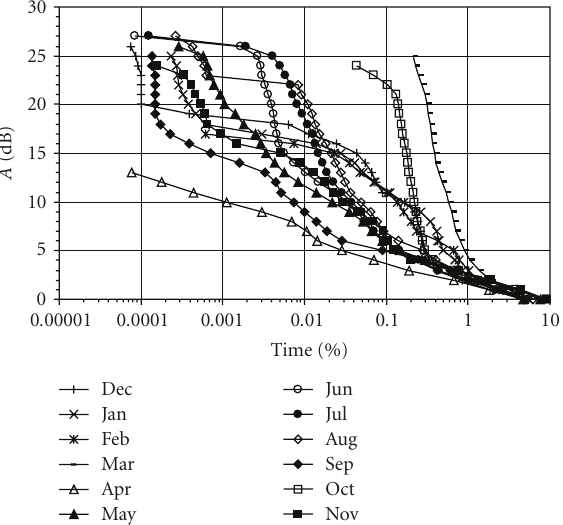
Figure 2: Obtained monthly CDs of attenuation due to all the hydrometeors combined on the FSO path over the 6-year period.